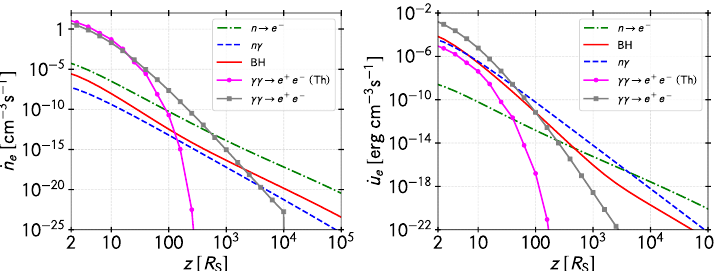
Figure 10. Injection of electrons and positrons in the funnel by all processes mentioned in the text. BH stands for Bethe-Heitler. Left panel: Number of pairs created per unit time and volume by the different processes. The curves of pairs created by photo-annihilation are divided into the contributions from MeV-MeV collisions (magenta line with circles) and those of non-thermal gamma-rays with soft photons (grey line with squares). Right panel: Same plot for the energy injected in pairs per unit time and volume.